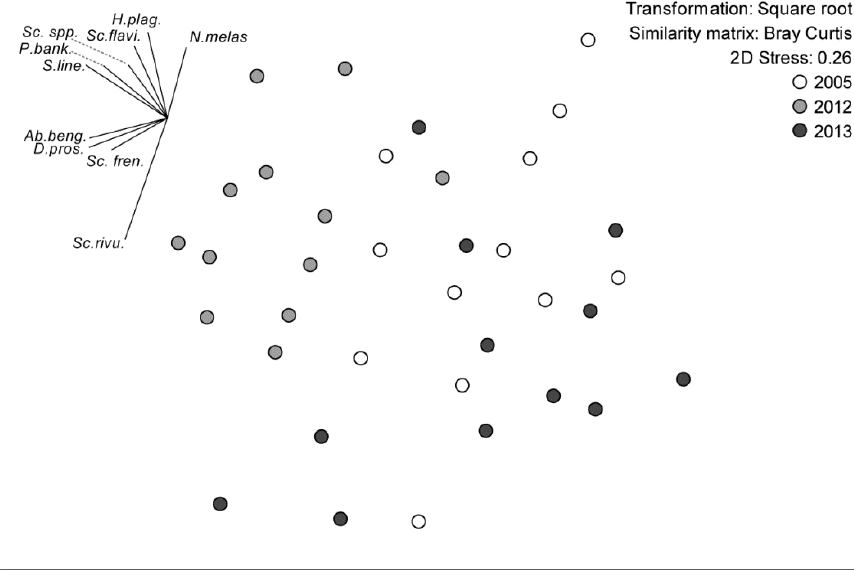
Figure A1.2. Taxonomic MDS on biomass of species; vectors calculated using multiple partial correlations in PRIMER 6.0 PERMANOVA +. 1 way ANOSIM with sites pooled: Global R=0.39. No groupings are apparent.